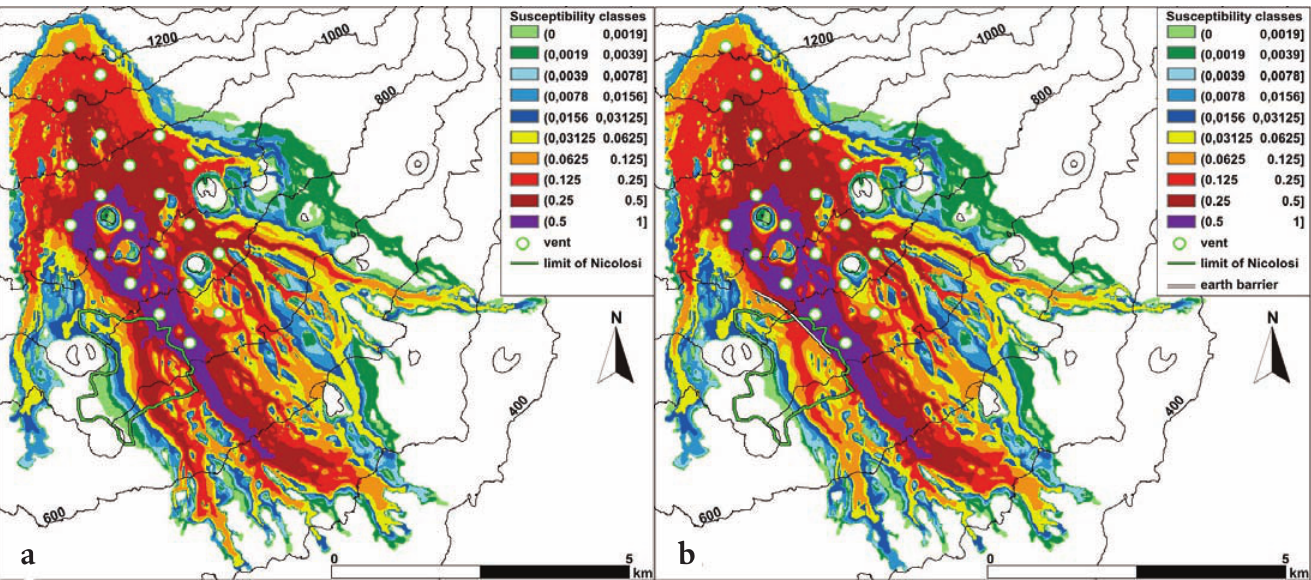
a Figure 7. (a) Map showing the population centers for the densely urbanised Nicolosi on the south flank of Etna, together with the location of a set of vents from which lava flows originated and the hazard zonation based on simulations. The eastern sector of Nicolosi appears to be the most exposed, with a narrow branch of medium-high hazard passing straight through the centre of the town. (b) Map showing the same area and the scenario from lava flows intersecting a hypothetical 2-km-long and 20-m-tall earth barrier to protect the centre of Nicolosi, which are re-simulated on a modified topography that includes the presence of the barrier. The embankment lowers the probability of lava flows inundating the centre of Nicolosi to some extent, as the hazard decreases.